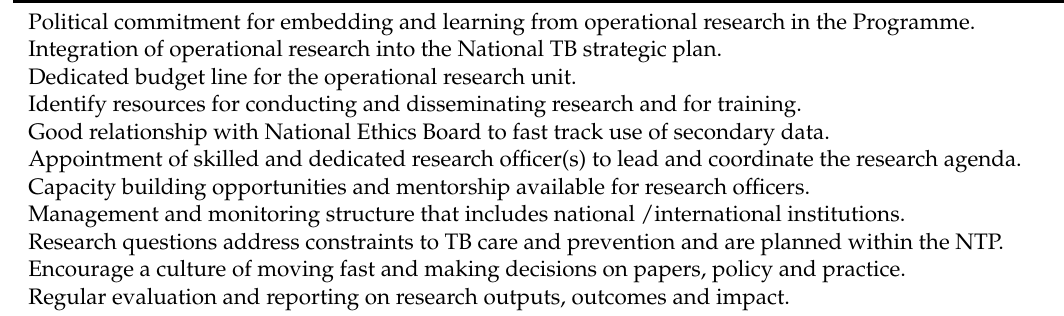
Table 5. Key steps for embedding operational research in a National TB